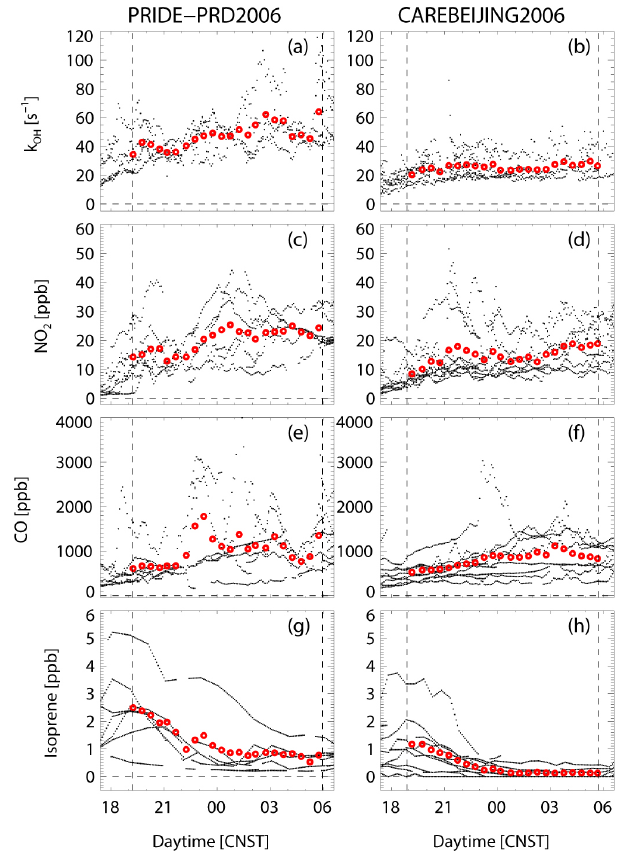
Figure 2. Observed values of k OH , NO 2 , CO, and isoprene during PRIDE-PRD2006 and CAREBEIJING2006. The black symbols de- note the original measurements, the red circles denote half-hourly averaged values for k OH , NO 2 , CO, and isoprene. The local sunset and sunrise time are marked by the dashed vertical lines.